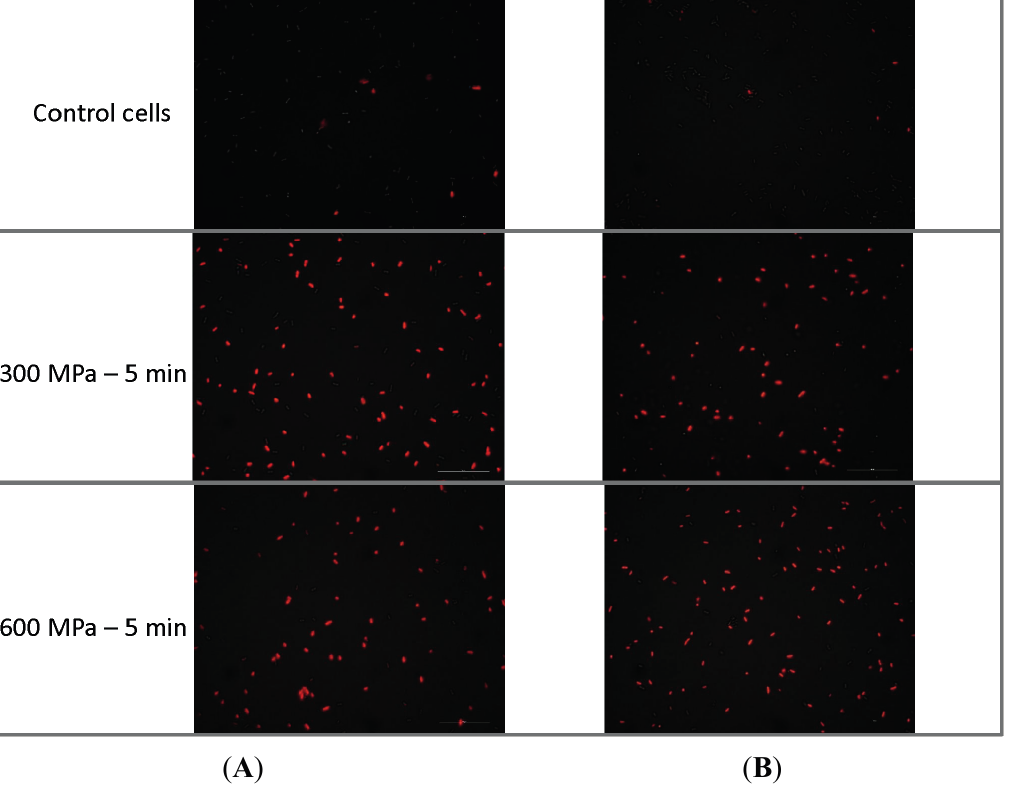
Figure 3. Representative electron micrograph sections of cells of Escherichia coli E218/02 ( A ) and Escherichia coli C-600 ( B ) untreated or treated with HHP at 300 MPa and 600 MPa. a: cytoplasmic membrane; b: cell wall; c: enlarged cell; d: disorganization of the genome area; e: condensation of cytoplasmic material in amorphous regions; f: membrane with winding shape; g: detached